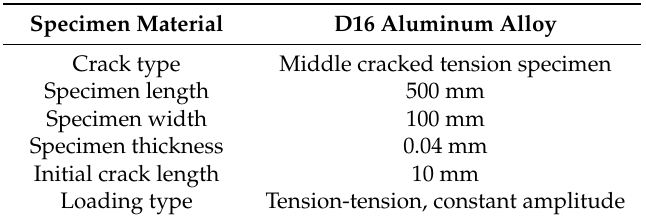
Table 5. The experimental information of D16 aluminum alloy.